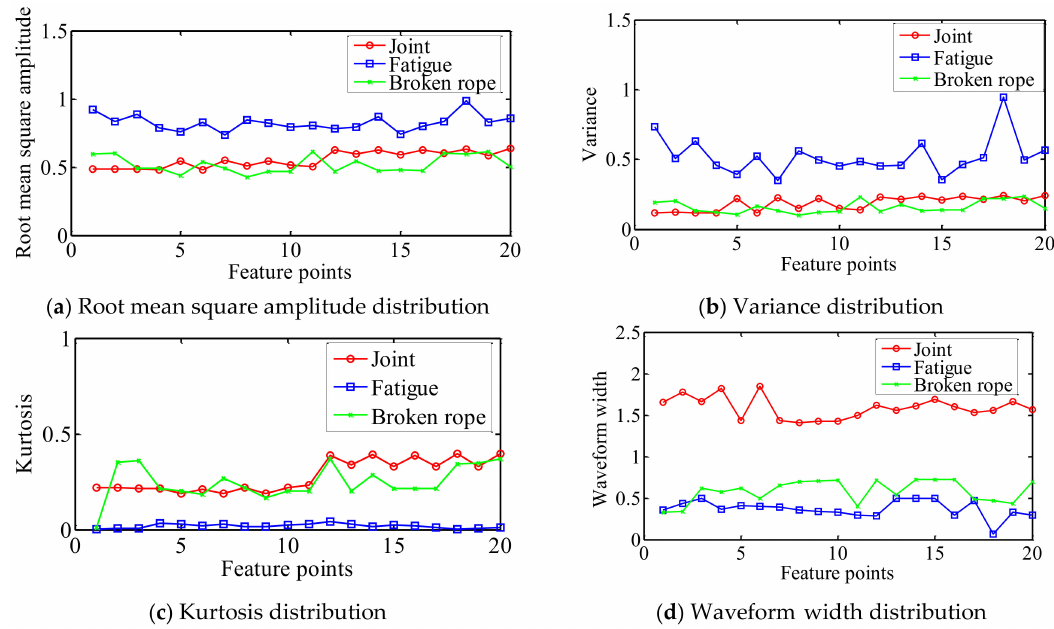
Figure 15. Features distribution for three types of normalized weak magnetic